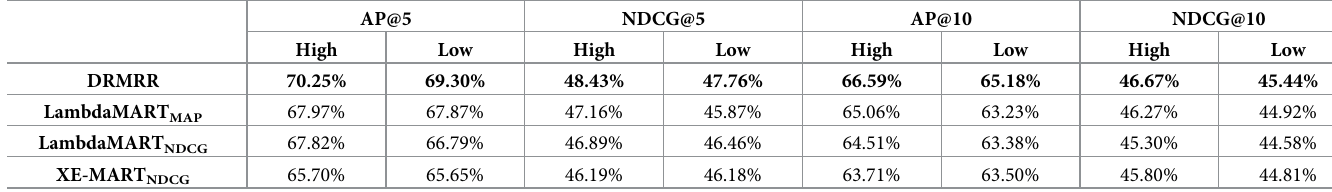
Table 3. The impact of label noise on the performance of ranking